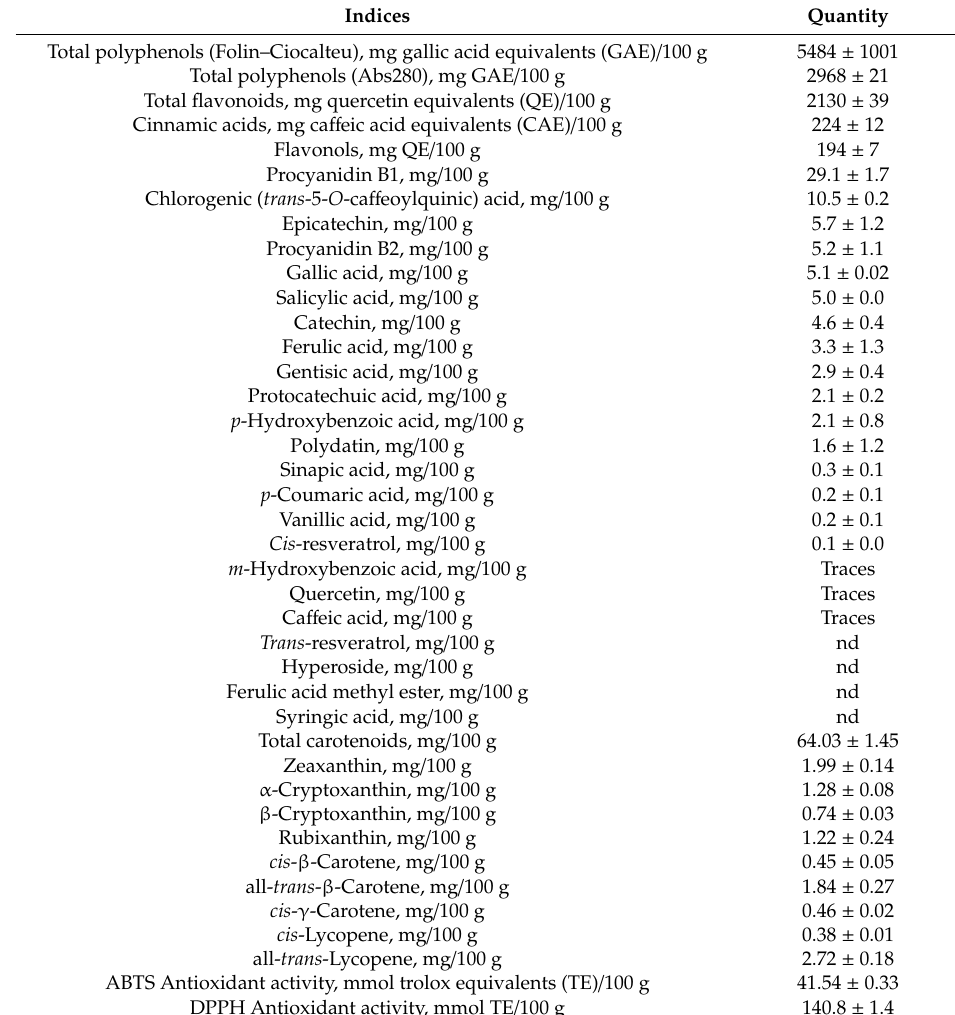
Table 1. The content of total and individual polyphenols, carotenoids and the antioxidant activity of the rose hip dry powder used for experiments (the results are expressed as means ± standard deviations of three